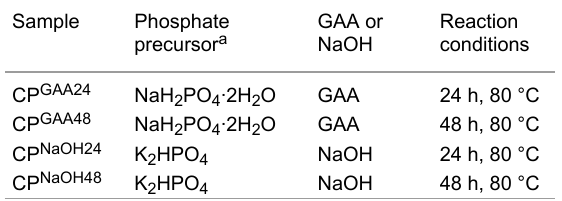
Table 1: Samples investigated in this study. CP is calcium phosphate, GAA is glacial acetic acid, 24 and 48 are reaction times in hours. Sample